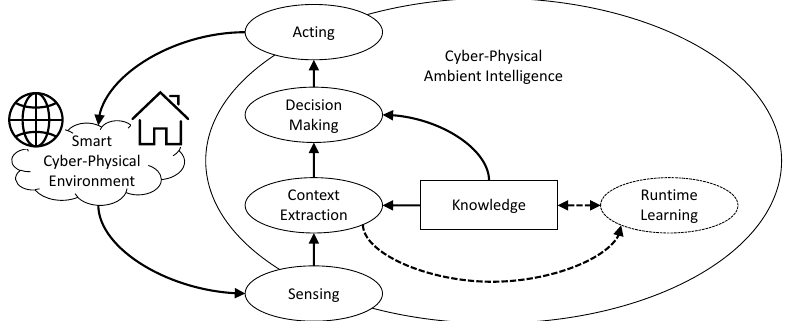
Figure 1. The ambient intelligence closed loop. Arrows denote information flow. Dashed lines are used to denote optional information